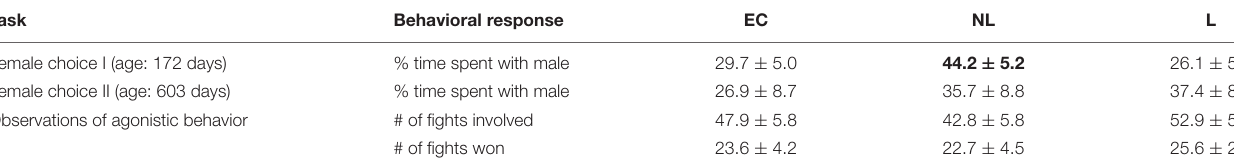
TABLE 2 | Effects of IntelliCage treatment on sexually selected traits. Task Behavioral response EC